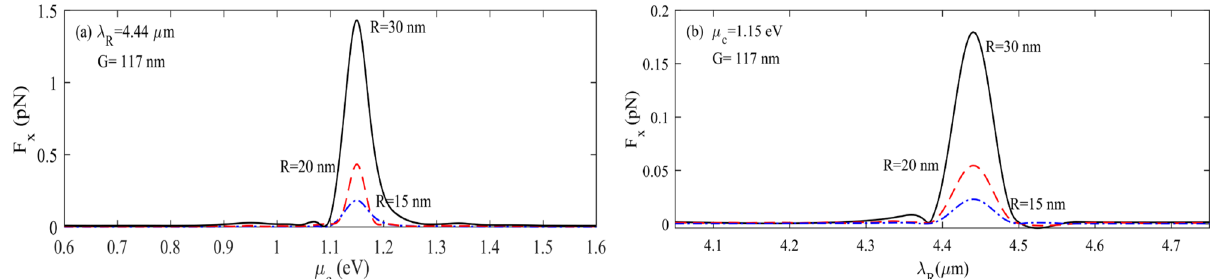
Figure 5. F x of particles with R = 15, 20 and 30 nm at ( a ) λ = 4.26 µm and µc between 0.8 and 1.7 eV and at ( b ) λ R between 3.8 and 4.7 µm and µc = 1.25